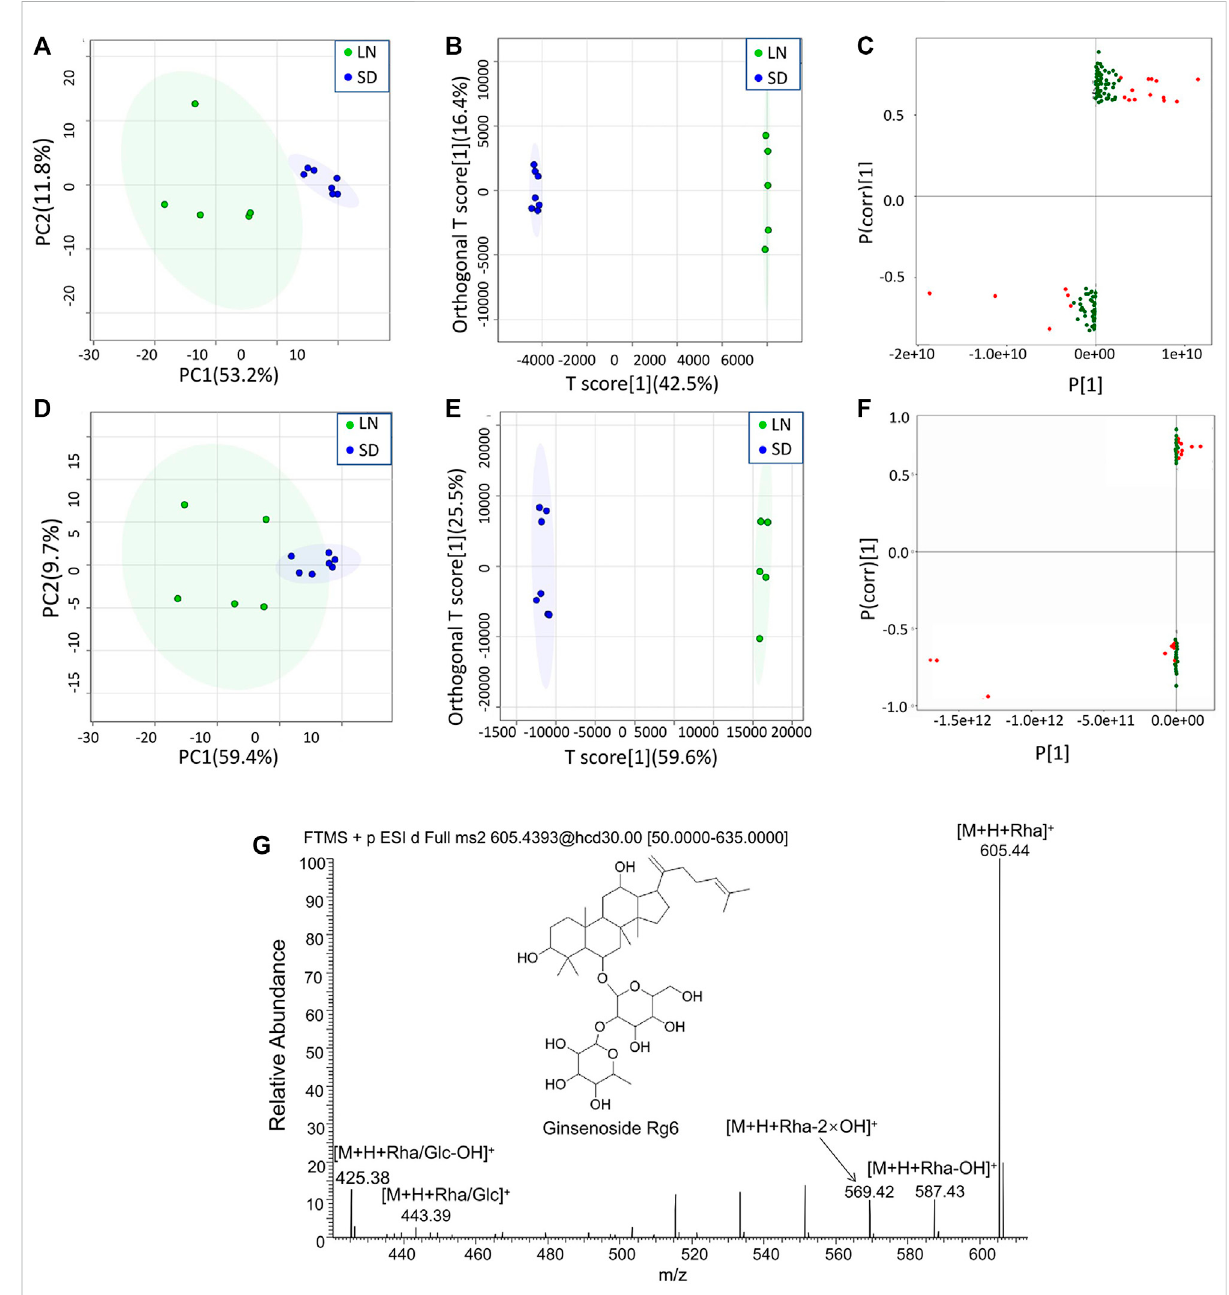
FIGURE 3 Multivariate statistical analyses of the metabolomic data of GF. (A) PCA scatter plot in the positive ion mode; (B) OPLA-DA scatter plot in the positive ion mode; (C) S-plots for the OPLA-DA in the positive ion mode; (D) PCA scatter plot in the negative ion mode; (E) OPLA-DA scatter plot in the negative ion mode; (F) S-plots for the OPLA-DA in the negative ion mode; and (G) MS2 spectra of ginsenoside